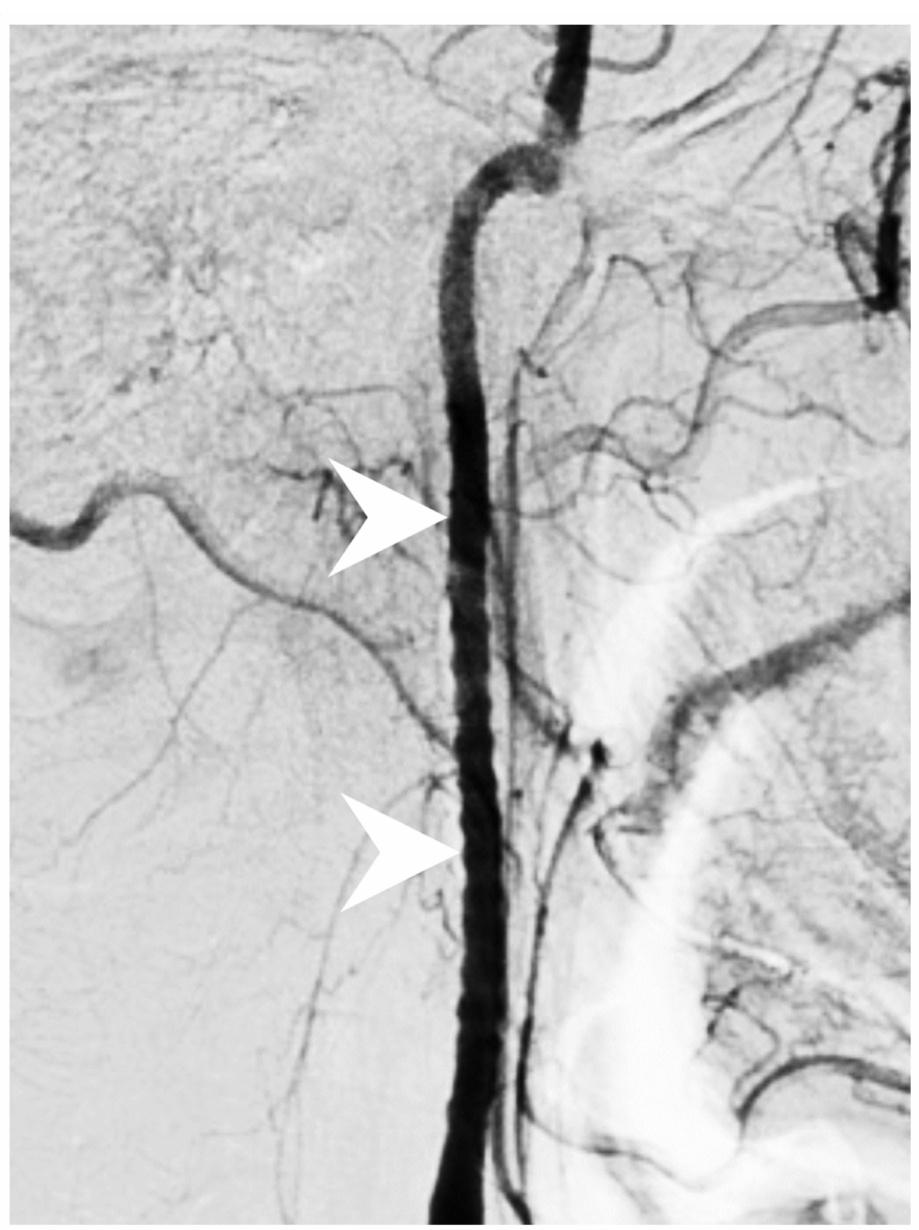
Figure 2. FMD is characterized by noninflammatory, nonatherosclerotic vasculopathy with no identi- fiable underlying cause [1]. FMD predominantly involves small to median-sized arteries and affects middle-aged individuals (30 to 50 years old) [2]. According to recent systemic review, cerebrovascular FMD is as common as renal FMD [2]. In contrast to sites susceptible to the atherosclerotic process (proximal internal carotid artery), cerebrovascular FMD commonly involves the middle to distal portion of the internal carotid artery. The most common symptoms of cerebrovascular FMD are pulsatile tinnitus and headache [3]. However, cerebrovascular FMD is frequently asymptomatic and is found by accident through an image examination. Devastating neurologic consequences, such as stroke and transient ischemic attack, can occur in symptomatic patients. Diagnosis of cerebrovascular FMD requires non- invasive and invasive image exams, including CTA, MRA and digital subtraction angiography (DSA). Non-invasive CTA and MRA are the modalities of choice whereas DSA remains the gold standard for the diagnosis of cerebrovascular FMD. Nevertheless, because of its invasiveness and risk of arterial dissection of the fragile vessels, DSA is commonly reserved for ambiguous cases and those requiring endovascular treatment. The typical imaging findings of cerebrovascular FMD are alternating luminal narrowing and dilatation, resulting in a “string-of-beads” appearance. Fusiform vascular ectasia and vascular loop are also typical features [4]. Other less typical features include aneurysm, arterial